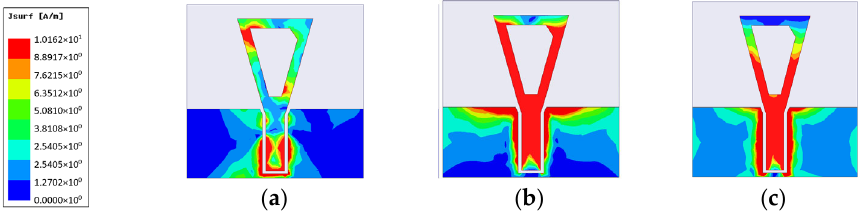
Figure 8, Surface current distribution of the proposed CPMS at different operation frequencies ( a )